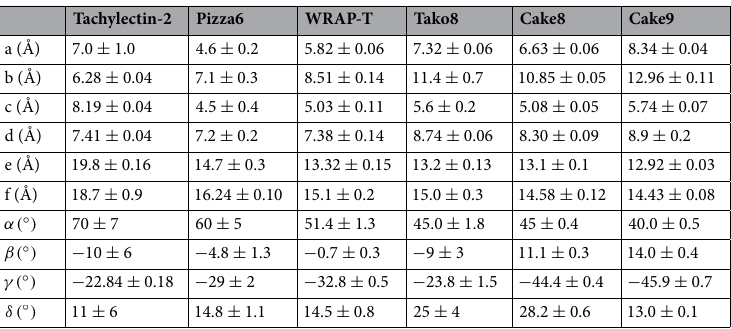
Table 3. Geometric parameters of symmetric designer